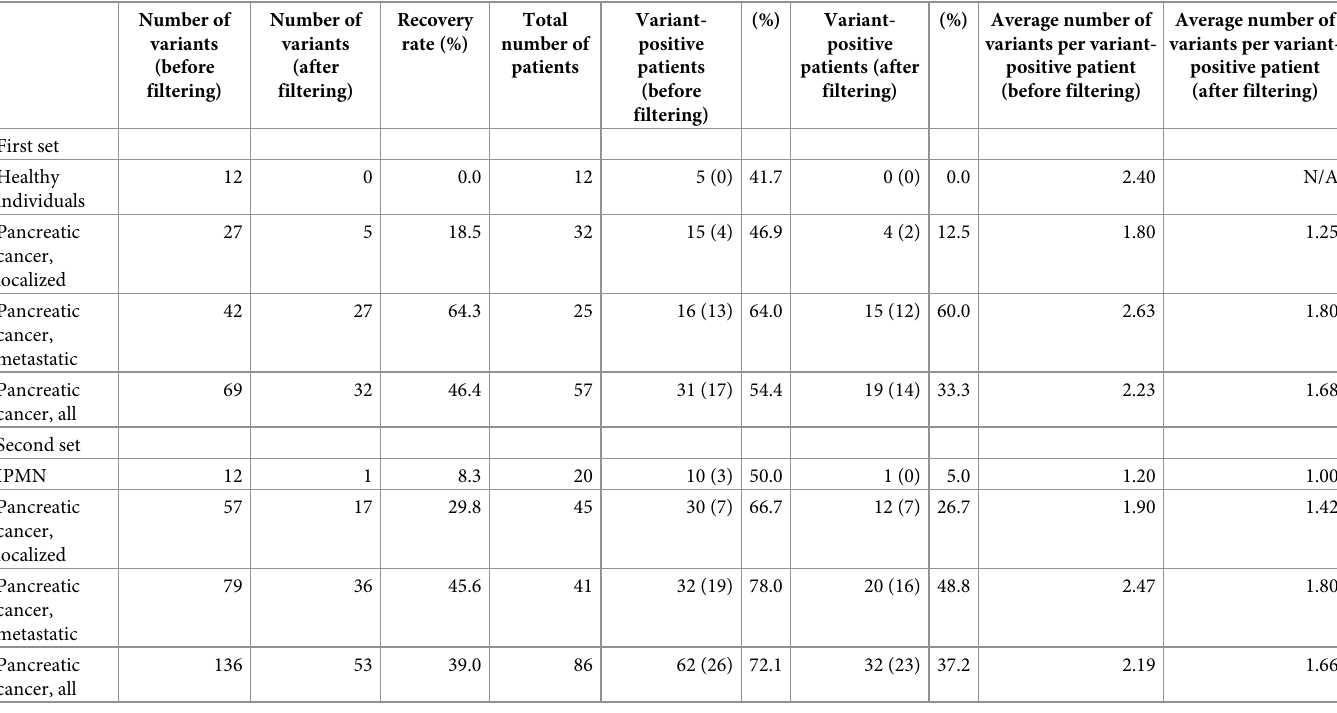
Table 1. Variants in pancreatic cancer identified by NOIR-SS and the CV78 filter.